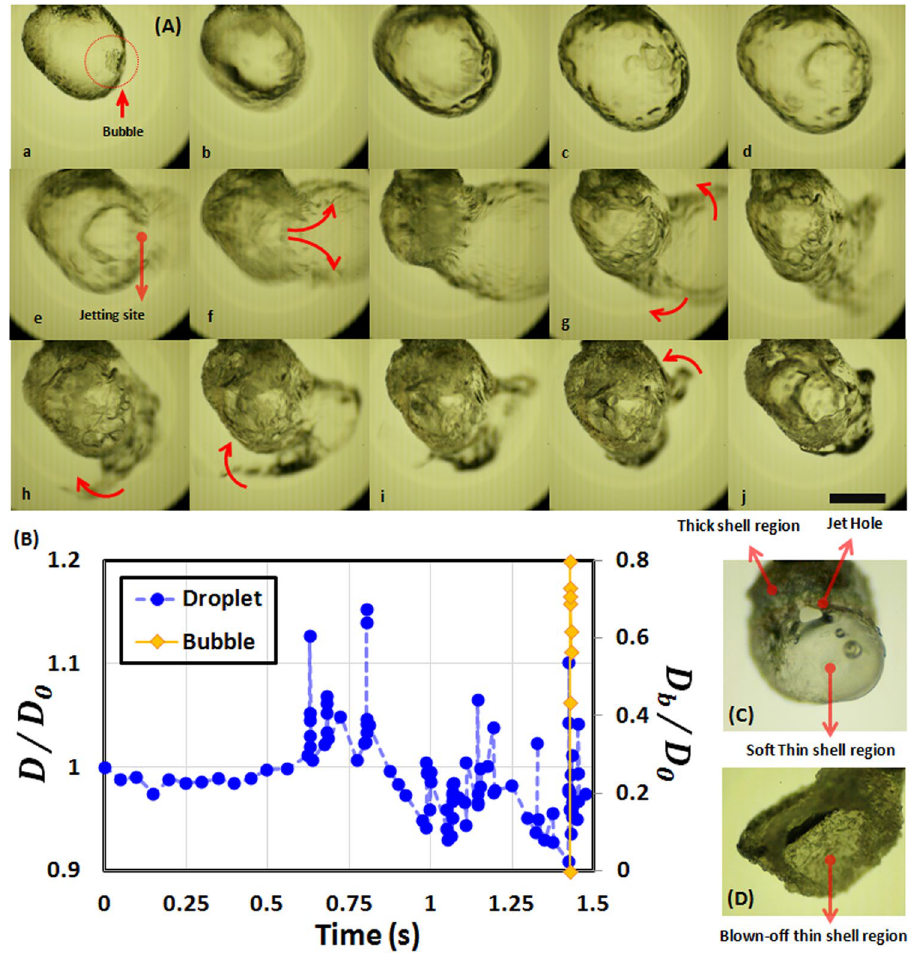
Figure 4. Bursting dynamics of a 5 wt.% gelled ethanol fuel droplet undergoing combustion. ( A ) High intensity rupture featuring a sequential transition from an initial smooth shell to a final inhomogeneous deformed state: (a) bubble nucleation; t = 0 ms, (b) rapid bubble expansion and coupled droplet swelling; 0.277, 0.416 ms, (c) state of maximum droplet dilatation; 0.833 ms, (d) Onset of rupture at weak soft spot; 0.972 ms, (e) shell collapse and formation of jetting site; 1.112 ms, (f) continual expansion of ruptured layer/ sheet due to rupture impact; 1.25, 1.527 ms, (g) sheet retraction; 1.945, 2.223 ms, (h) sheet collapse back onto the droplet surface at random locations; 2.638, 3.194, 3.472, 3.889 ms and (j) formation of a new non-uniform shell; 5 ms. The scale bar equals 1 mm. ( B ) Time history of normalized bubble D D ( / ) and droplet diameter D D ( / ) . Transient spikes correspond b 0 0 to pressure surges resulting from rapid bubble growth. ( C ) Microscopic image of the final combustion